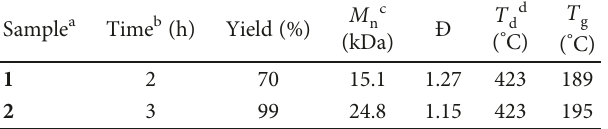
Table 1: Polymerization